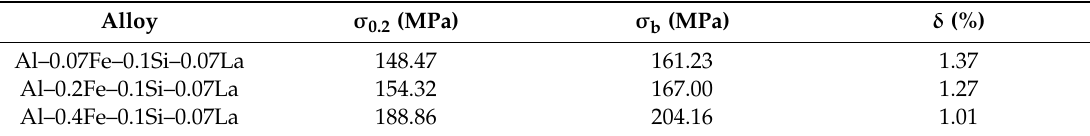
Table 1. Tensile strength of the Al–xFe–0.1Si–0.07La alloy